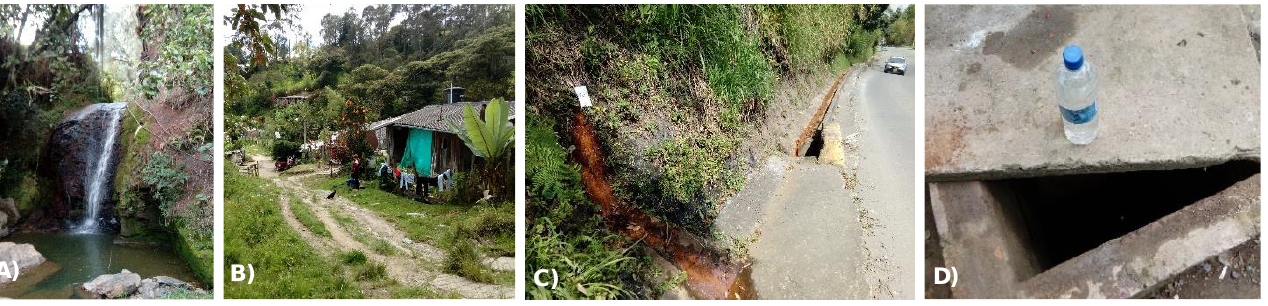
Figure 8. Points where water samples were collected: ( A ) in the El Palenque catchment; ( B ) Las Flores drainage (behind the houses), on the road to Las Amarillas village; ( C ) at the bottom of the drain on the national road, south of the study area, with reddish patinas due to oxidized iron sulfides; ( D ) in a cistern inside a house, La Esperanza neighborhood.